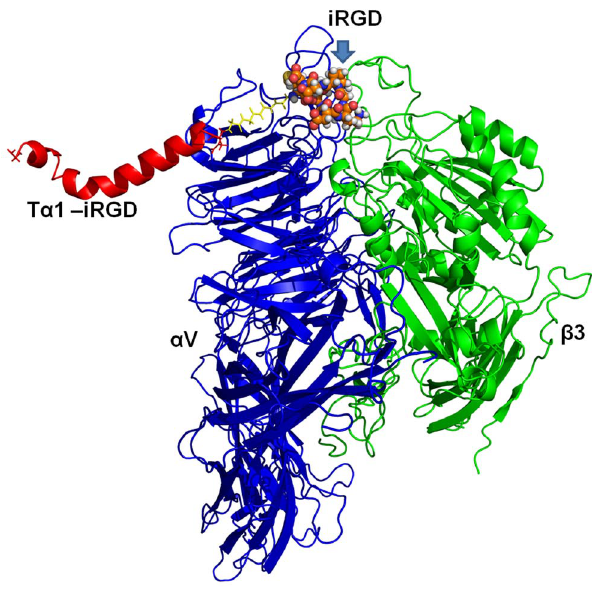
Figure 7. Structure of integrin a v b 3 complexed with T a 1-iRGD. The structure of a v and b 3 subunits, respectively, in a ribbon-like structure. The T a 1 part of T a 1-iRGD is shown in red, the iRGD part is shown as a spherical structure, and the linker between them is shown in yellow. The a v b 3-T a 1-iRGD structure reveals that the iRGD of T a 1-iRGD inserts into a crevice between a v and b 3 on the integrin head, sharing a similar interaction manner with the structure of a v b 3 in complex with a cyclic RGD ligand (PDB file code:1L5G).